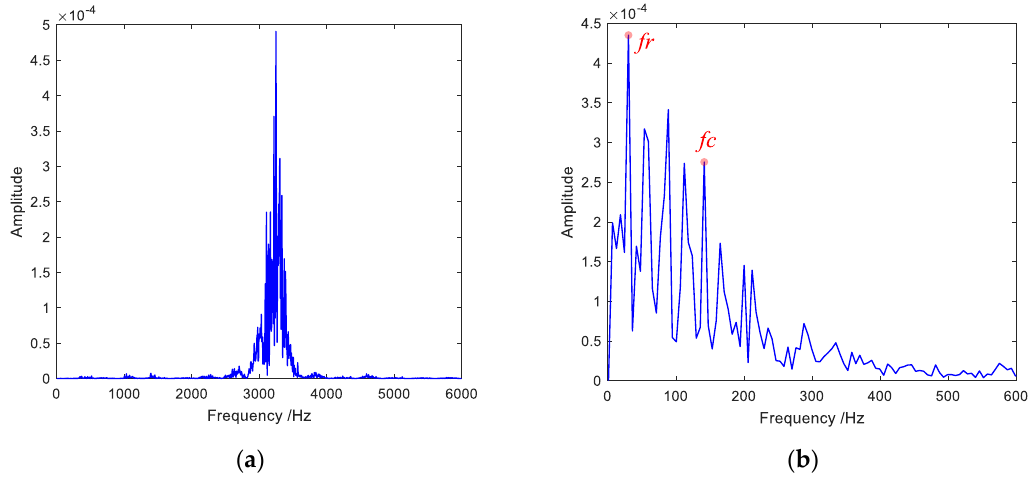
Figure 18. Results based on SVD in case 2: ( a ) The frequency spectrum of the recovered signal (2800 Hz to 3800 Hz); ( b ) envelope spectrum.